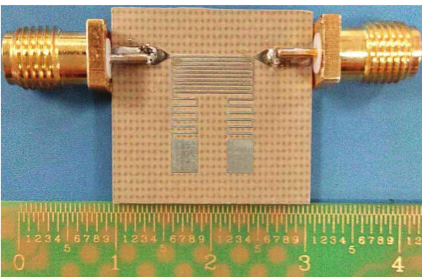
Figure 4: Photograph of the proposed filter.